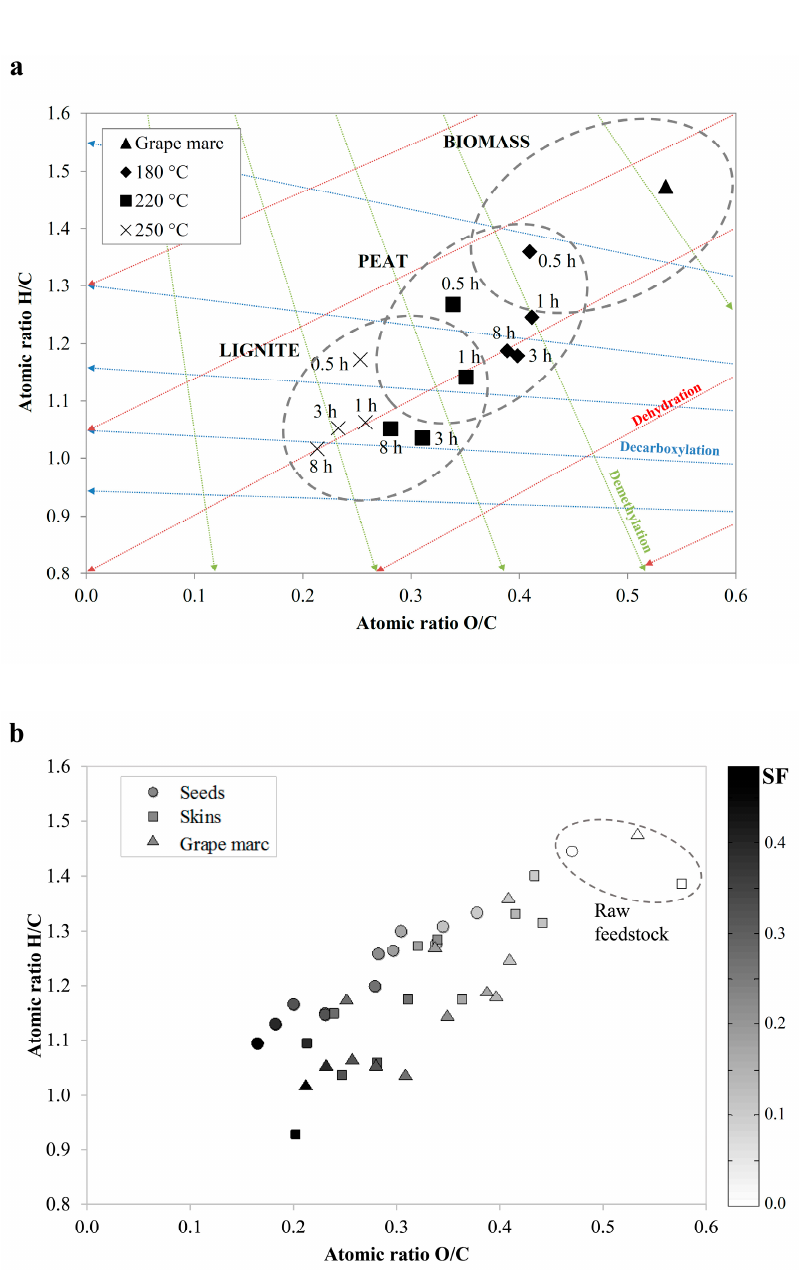
Figure 2. Van Krevelen diagram of grape marc ( a ) and degree of carbonization vs. severity factor ( b ).